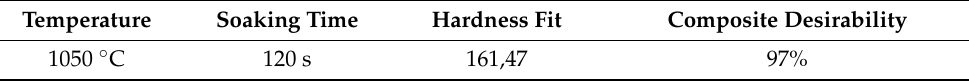
Table 5. Solution proposed by Minitab software to obtain the hardness target of 160